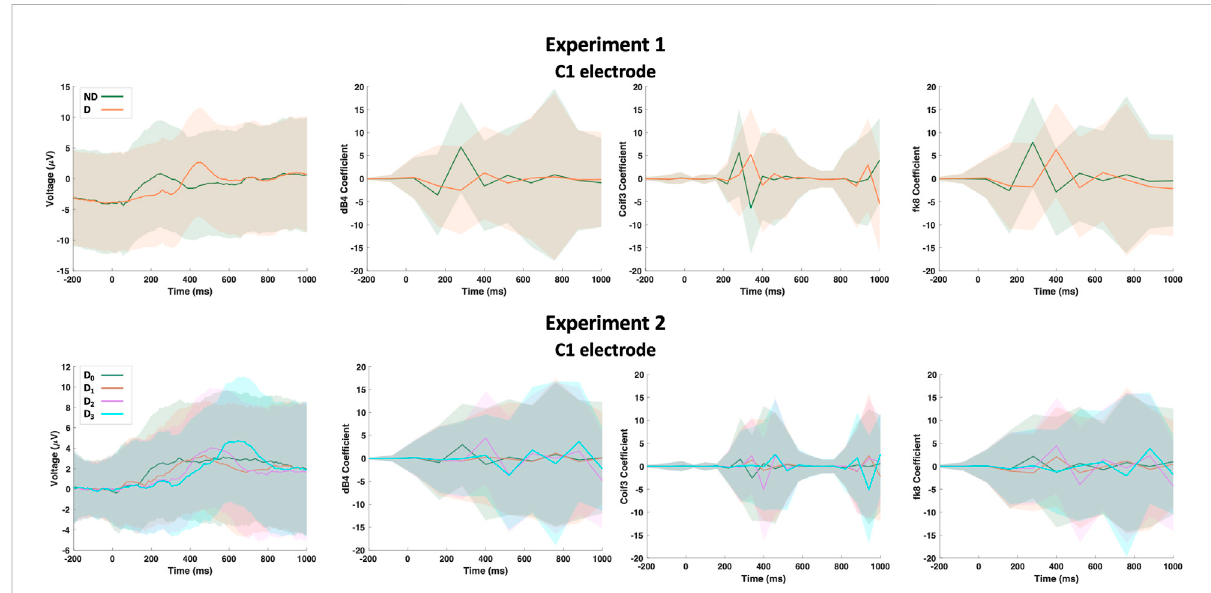
FIGURE 3 A sample of the dataset showing the raw EEG data and its wavelet transform based on Daubechies-4 (dB4), Coi fl et-3 (Coif3) and Fejér- Korovkin-8 (fk8) wavelets for C1 electrode. Hard lines show the mean of the trials while shaded regions shows the standard deviation.